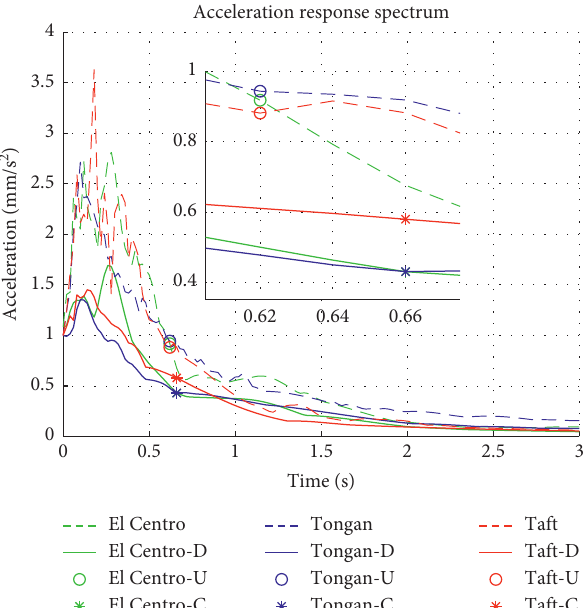
Figure 19: Pseudoacceleration response spectrum.